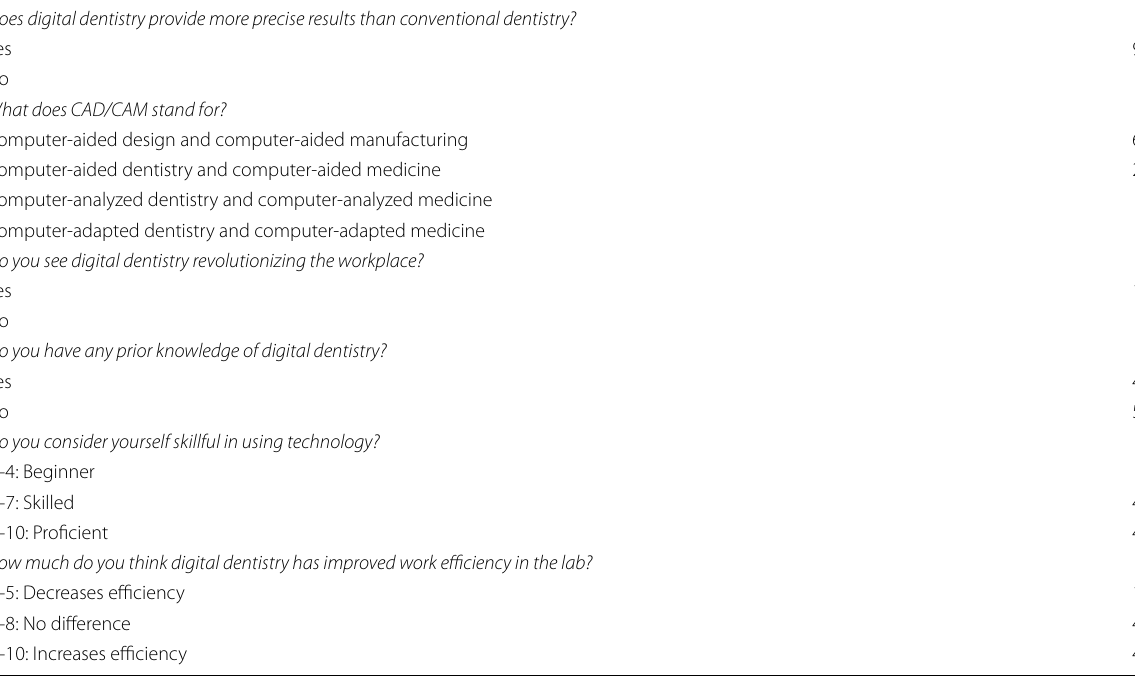
Table 3 Students’ perception of digital